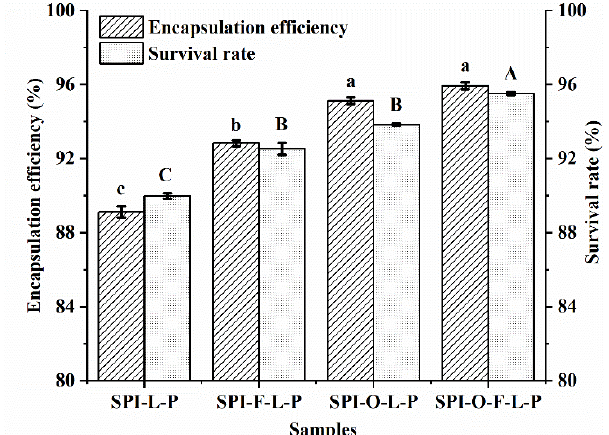
Figure 2. Effects of different substrates at their optimal amounts on the EE and SR of probiotics encapsulated in SPI-L-P, SPI-F-L-P, SPI-O-L-P, and SPI-O-F-L-P. Different lowercase letters denote significant differences of EE between samples and different uppercase letters represent significant differences of SR between samples ( p < 0.05).